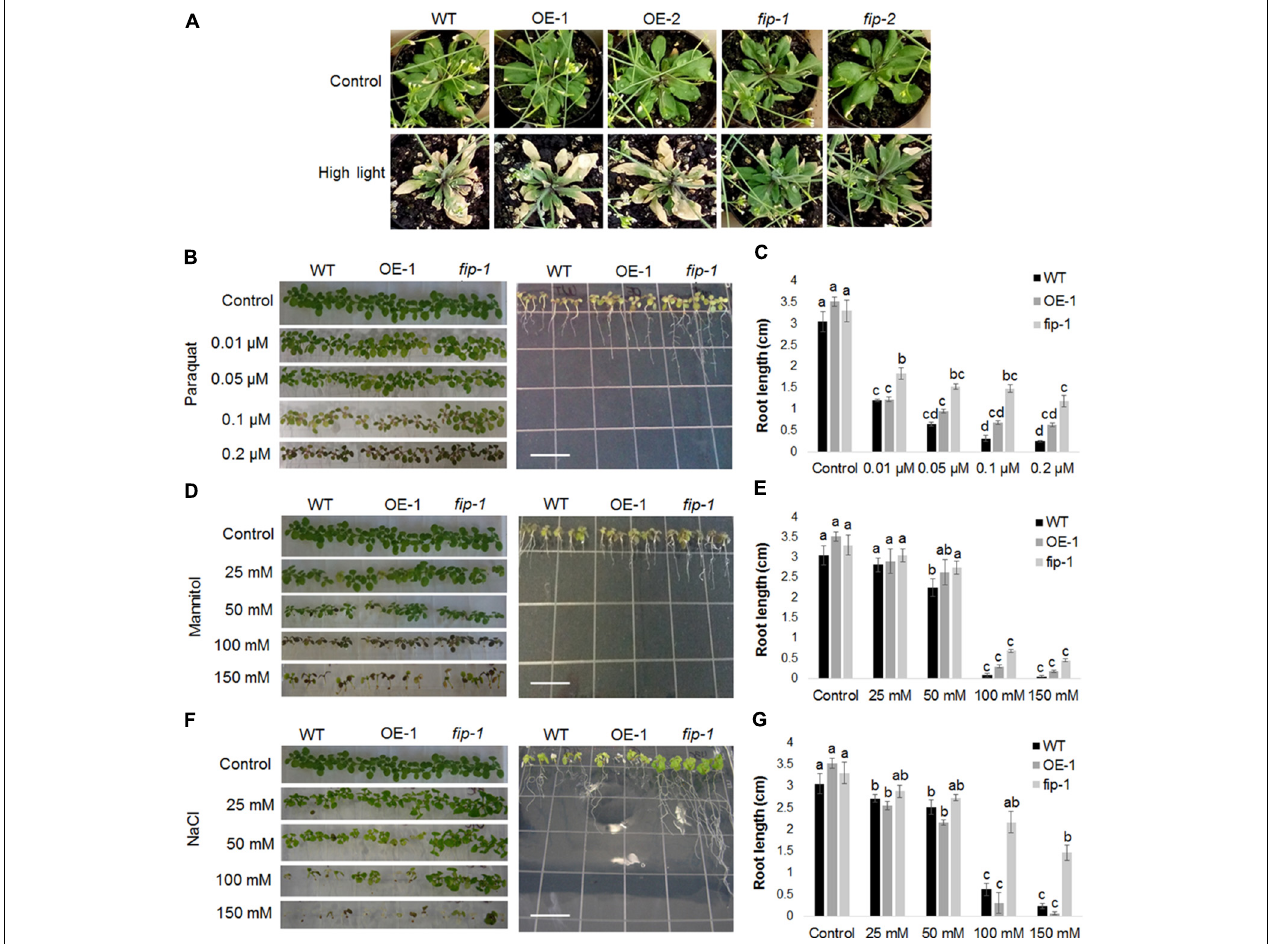
FIGURE 7 | The fip knockdown mutants are more tolerant to abiotic stress. (A) Effects of high light stress on plants expressing different amounts of FIP transcripts. Three-week-old WT plants, FIP overexpression lines (OE-1 and OE-2), and fip knockdown mutants ( fip-1 and fip-2 ) growing under control conditions (22 ◦ C, 16 h/8 h light/dark, 120 µ mol m − 2 s − 1 ) were subjected to high light stress (22 ◦ C, 16 h/8 h light/dark, 400 µ mol m − 2 s − 1 ) for 11 days. Plants were watered every 2 days throughout the period. (B–G) WT plants, an FIP overexpression line (OE-1), and the fip knockdown mutant ( fip-1 ) were grown in 0,5X MS plates for 7 days and then transferred to the respective stress treatment for 10 days. The plates were maintained in a room under control conditions (22 ◦ C, 16 h/8 h light/dark, 120 µ mol m − 2 s − 1 ). (B) Plants subjected to oxidative stress. Effect of increasing amounts of paraquat (0.01, 0.05, 0.1, and 0.2 µ M) on plant leaves (left). Effects of 0.2 µ M of paraquat on plant root growth (right). (C) Average root length of plants subjected to increasing amounts of paraquat. (D) Plants subjected to osmotic stress. Effects of increasing amounts of mannitol (25, 50, 100, and 150 mM) on plant leaves (left). Effects of 100 mM of mannitol on plant root growth (right). (E) Average root length of plants subjected to increasing amounts of mannitol. (F) Plants subjected to salt stress. Effects of increasing amounts of NaCl (25, 50, 100, and 150 mM) on plant leaves (left). Effects of 100 mM of NaCl on plant root growth (right). (G) Average root length of plants subjected to increasing amounts of NaCl. All the concentrations were tested in three independent experiments with three repetitions each time with identical results. Data are the mean ± SD ( n = 6). Statistically significant differences are indicated by different lower-case letters (One-way ANOVA followed by Tukey, P < 0.05). Scale bar (white) in plates means 1